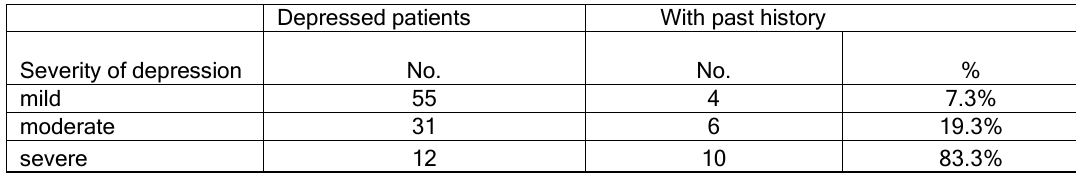
Table(3)The severity of depression in relation to past history of